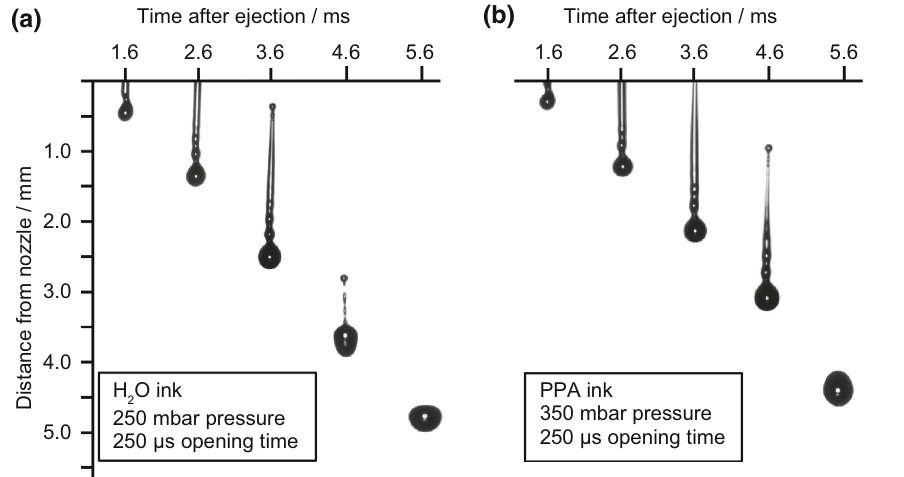
Fig. 1 Time sequence illustrating drop formation for the ( a ) water based ink and ( b ) the propionic acid based CGO ink. The images shown are for the printing parameters used during infiltration. The formation of a single drop with a known volume and velocity was achieved by adjusting the ink reservoir pressure and nozzle opening